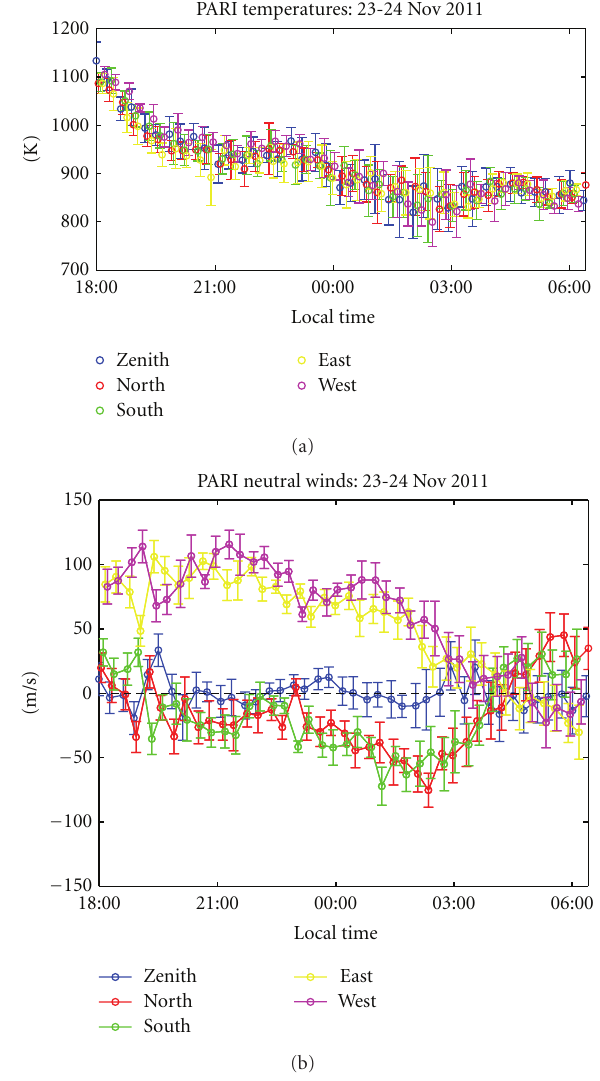
Figure 5: Observations of (a) temperatures and (b) winds made with the PARI FPI instrument for 23-24 November